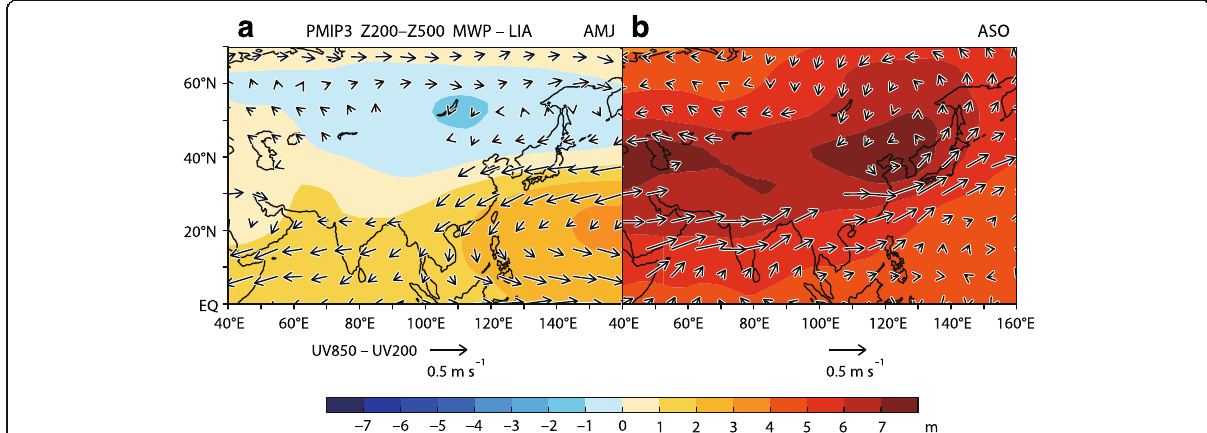
Fig. 3 Similar to a Fig. 2a and b Fig. 2b, but for tropospheric thickness (m) between the 200 and 500 hPa levels. Vectors indicate vertical wind shear (m s − 1 ) between 850 and 200 hPa